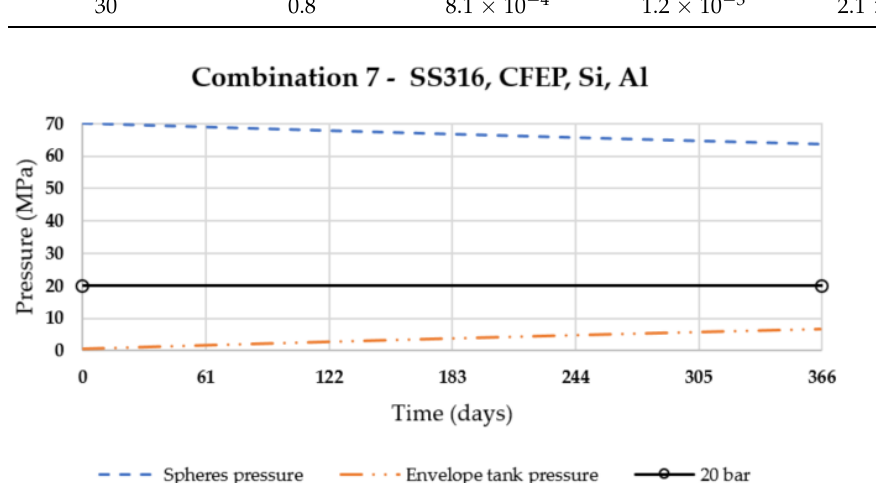
Figure 3. Pressure inside of the spheres and the envelope tank, combination 1 from Table 3.